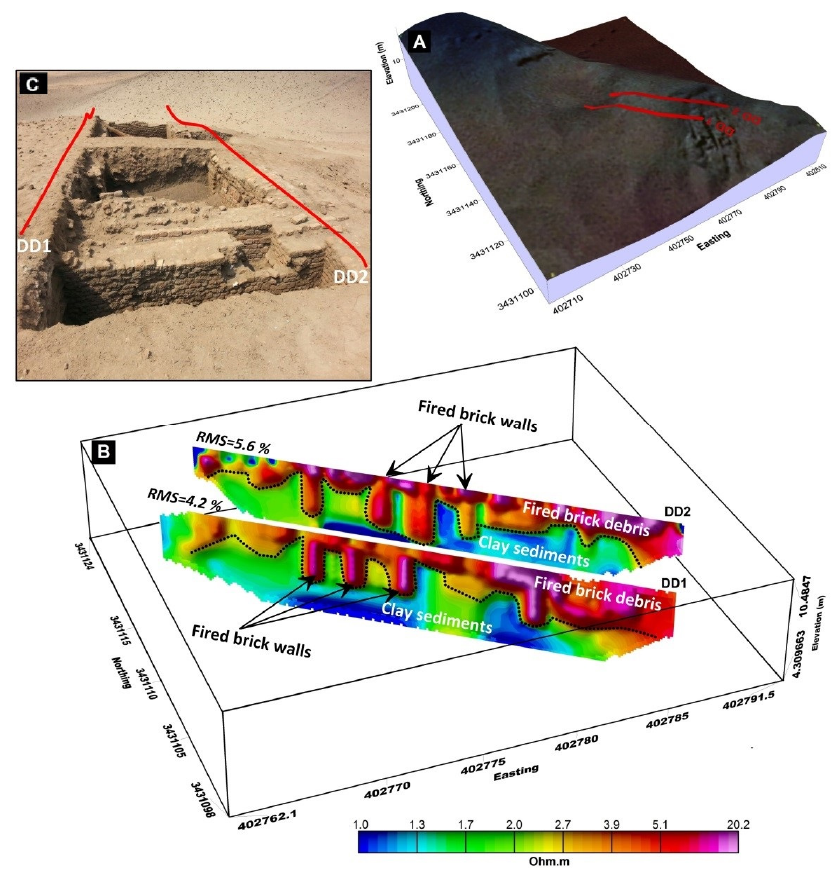
Figure 9. Results of 2D ERT at the area around Spot B: ( A ) 3D geometry of the actual location of the 2D ERT profiles, DD 1 and DD 2; ( B ) pseudo-3D inverted models; and ( C ) photo of an unearthed fired brick wall.